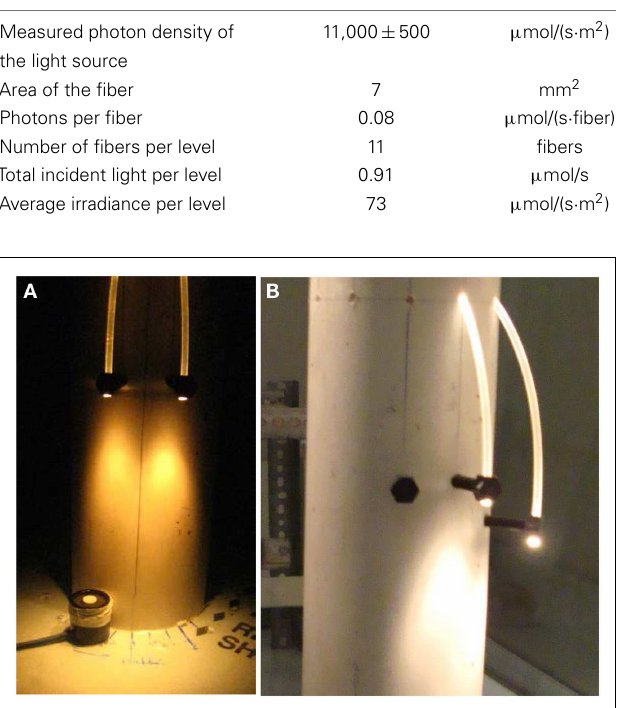
FIGURE 3 | (A) Measurement of light levels inside the photobioreactor; (B) Different level spacing’s under consideration.